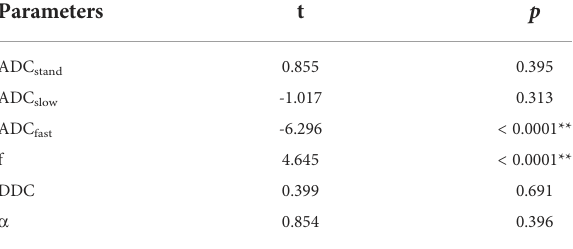
TABLE 2 Comparison of mean IVIM-parameters for tuberculous spondylitis and spinal metastasis.